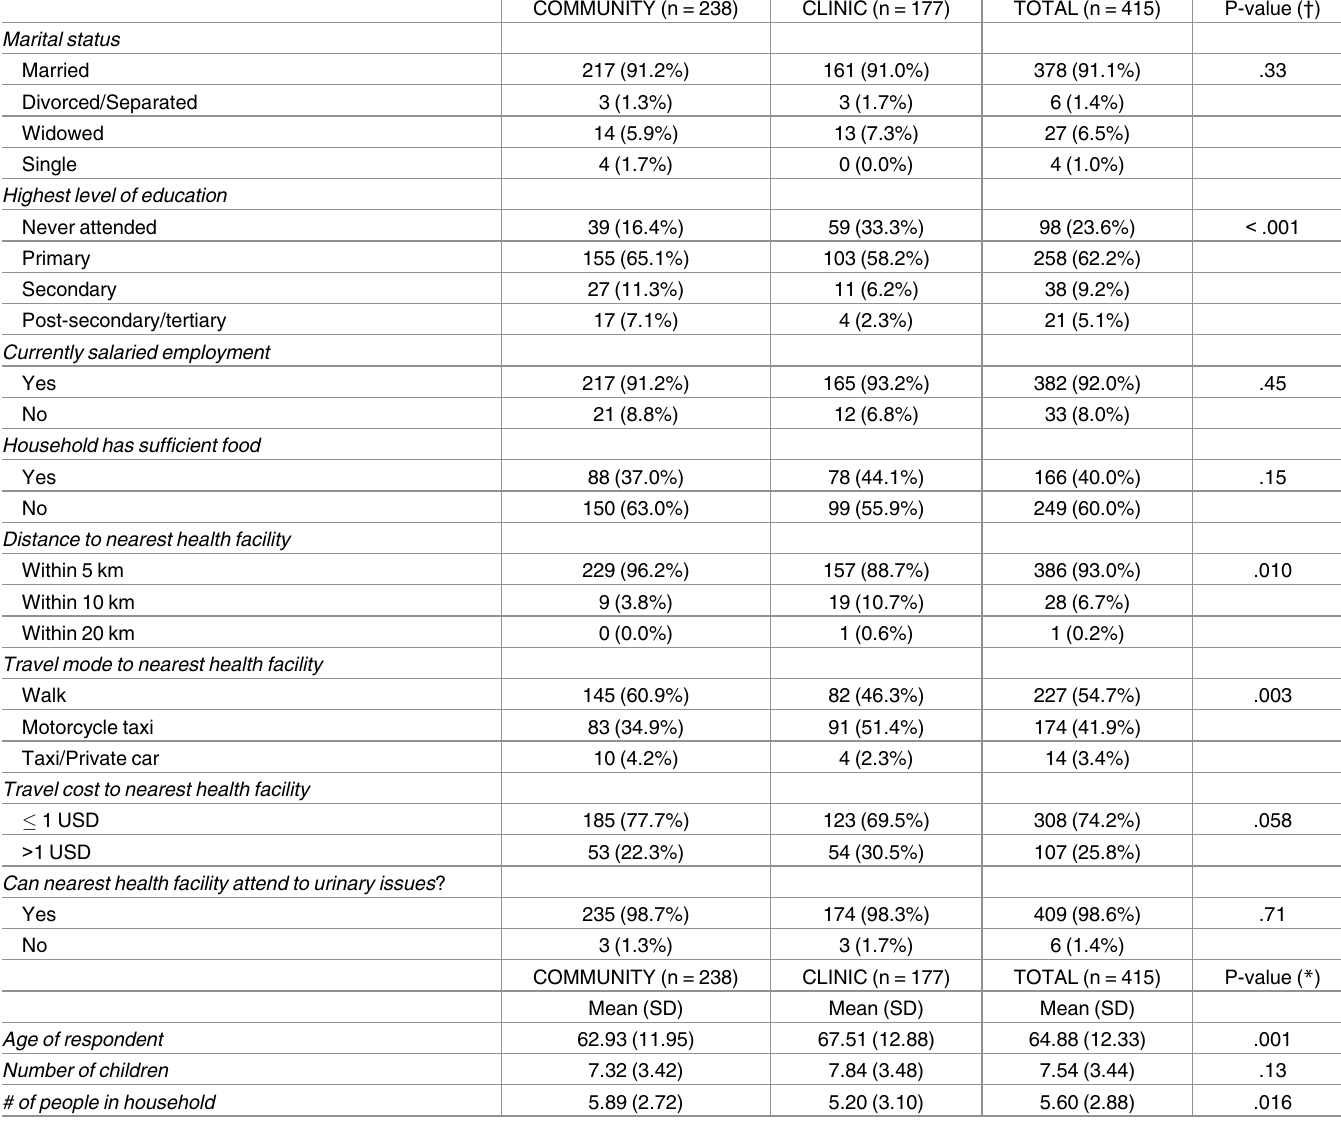
Table 1. Comparison of sites by demographic